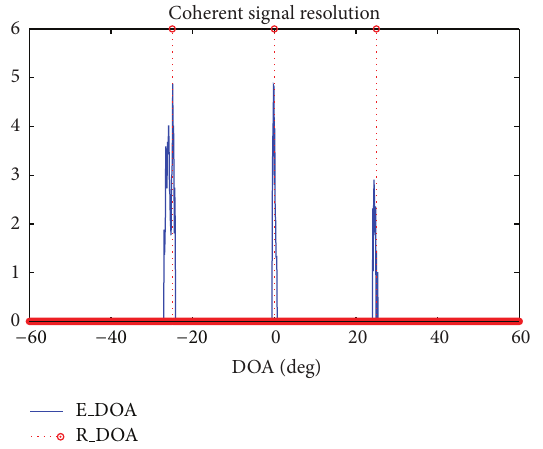
Figure 9: Coherent signal resolution simulation based JS-SR.